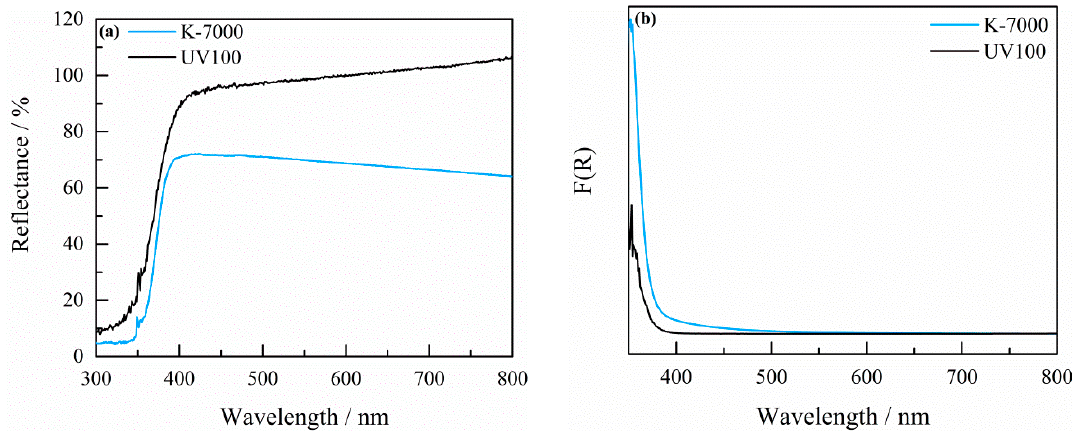
Figure 2. ( a ) Diffuse reflectance spectra (DRS) and ( b ) Kubelka–Munk functions of K-7000 and Hombikat UV100.